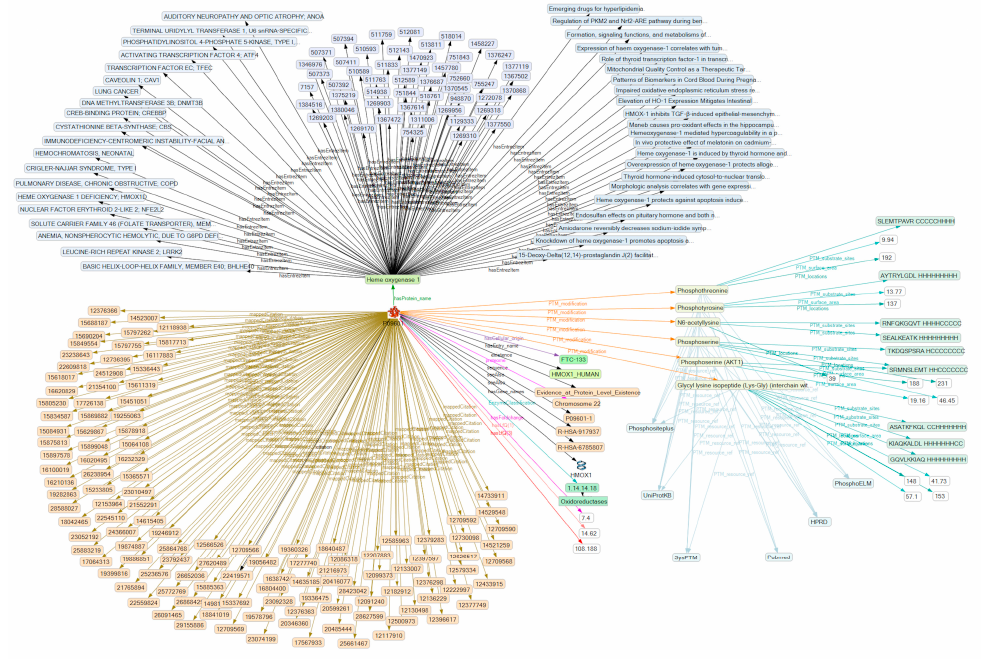
Figure 4. Results of a KE-mediated comprehensive search for information about HMOX-1 in UniProt, NLM-reference databases, and Reactome. The upper half shows NCBI Entrez data about HMOX1 restricted to thyroid (left to right: OMIM, Biosystems, Pubmed—violet blue); the lower left to center shows UniProt data (brown). On the right of the center line are classified PTMs (yellow-green) from dbPTM with their reference resources attached (light blue). (This is a high-resolution picture. A reader interested in detail may zoom in to amplify.).